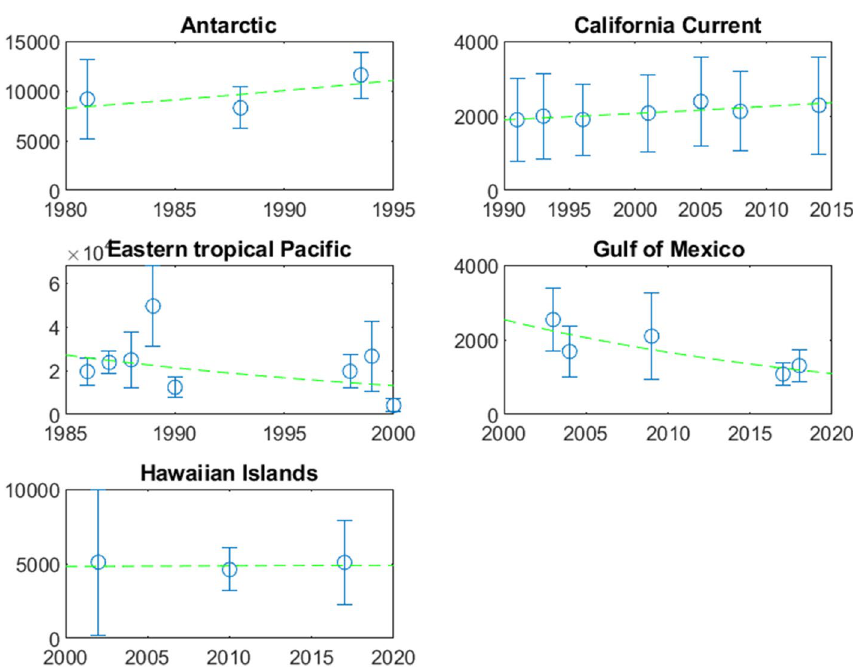
Figure 3. Trends in the estimated populations of sperm whales in five study areas where repeated surveys covered at least 10 years and there were at least 3 such surveys. Error bars indicate standard errors, and trend lines are shown (see Table 3 for further